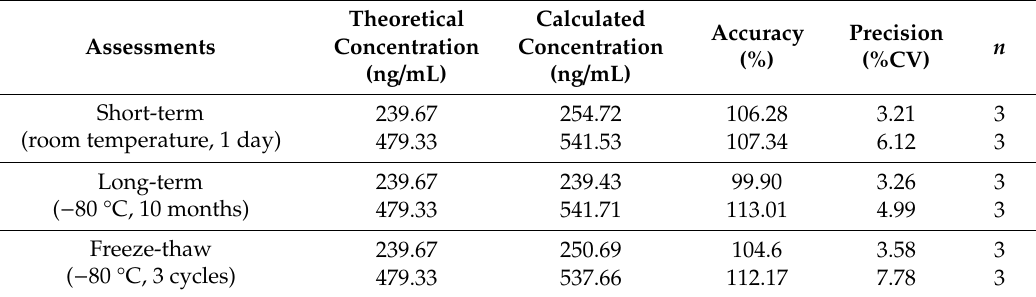
Table 3. The preliminary stability assessments in rat plasma.